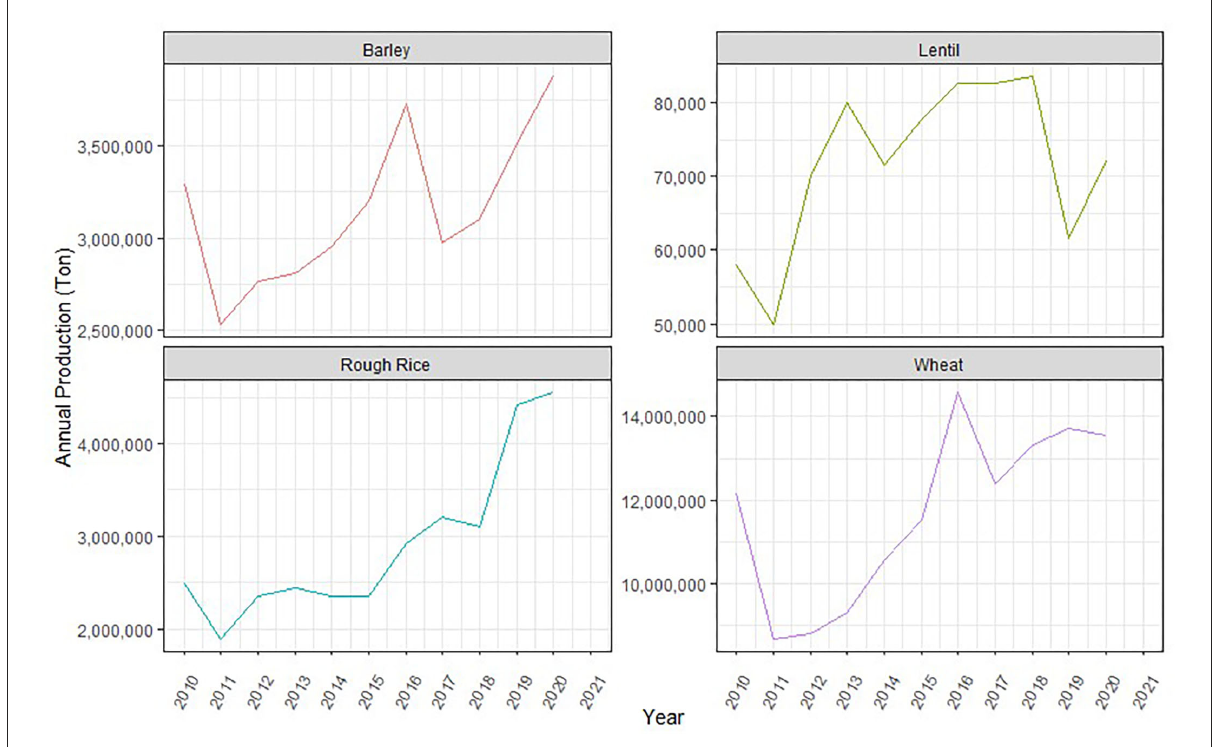
FIGURE5 Annual domestic production for four commodity crops: rice, wheat, barley, and lentils [Source: Statistical Yearbooks, Ministry of Agriculture in Iran (https://maj.ir/)].